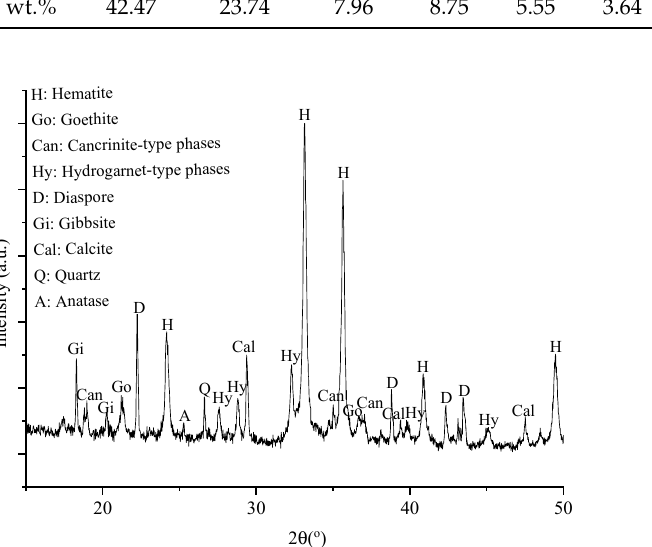
Figure 2. Mineralogical composition of bauxite residue.